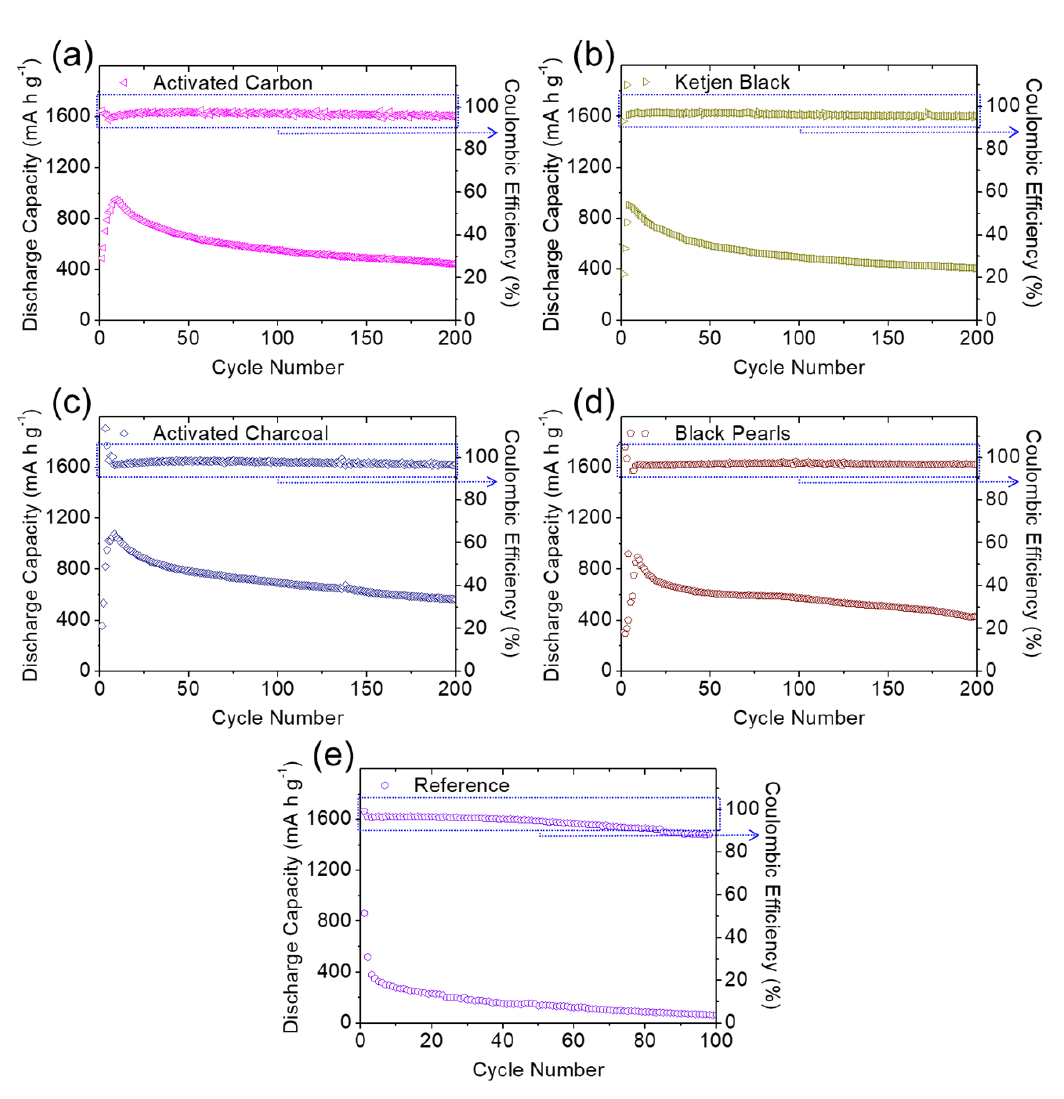
Table 2. Electrochemical characteristics: cell performance of the high-loading sulfur cathode in the lean-electrolyte cells with different carbon coating modules.